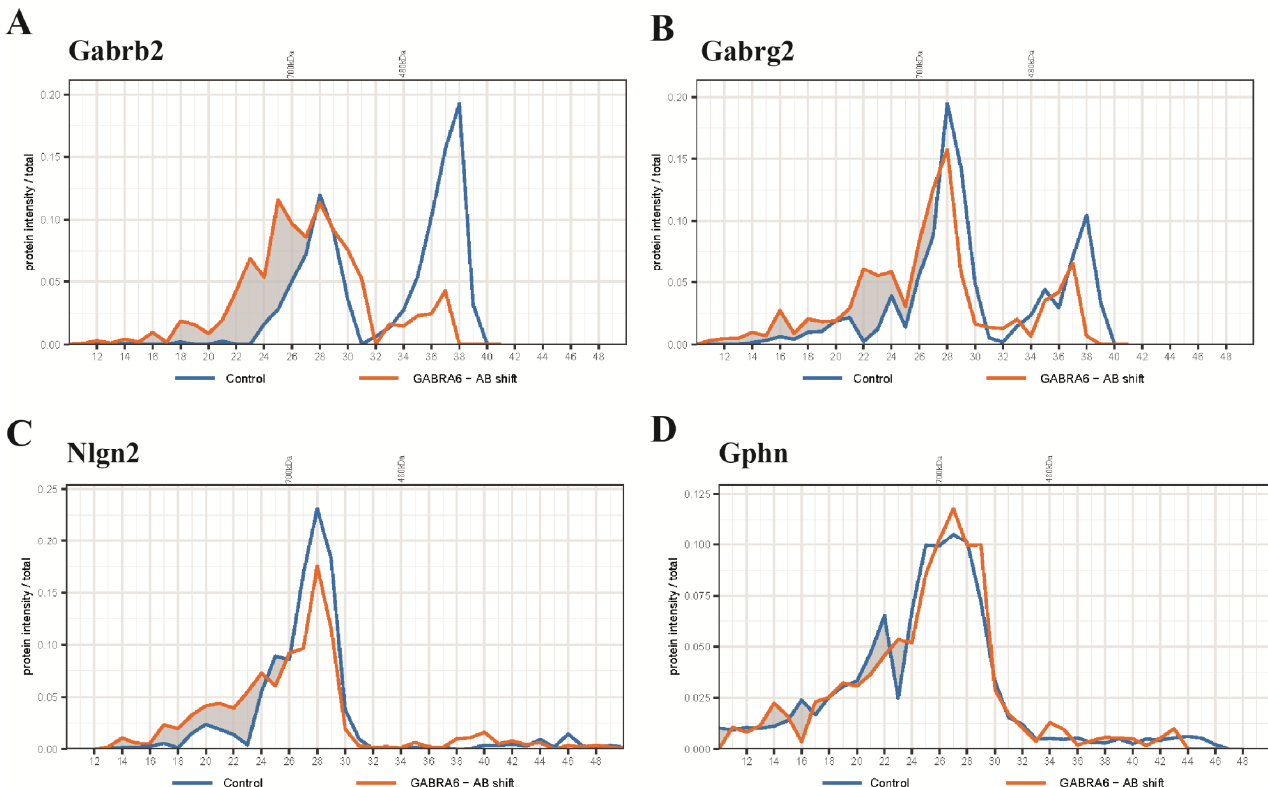
Figure 3. Protein profiles of selected proteins from an anti-α6 antibody shift experiment identified by mass spectrometry. ( A ) Pre-incubation of cerebellar extract with anti-α6 antibody shifted β2-containing complexes globally to a higher molecular weight in the BN. ( B ) The antibody shift reduced the amount of γ2-containing complex at 450 kDa and caused a small fraction of the complex at 680 kDa to increase in weight to around 750 kDa. ( C ) Nlgn2 demonstrated an up-shift from 680 kDa to 750 kDa and the shifted fraction overlapped with the shifted γ 2-containing complex. ( D ) This antibody shift did not affect the migration pattern of